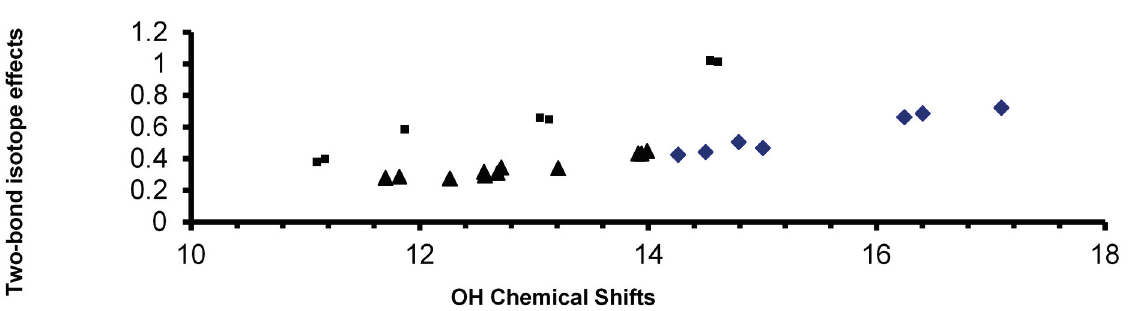
Figure 8. Plot of two-bond isotope effects vs. OH chemical shifts. Data taken from Refs.